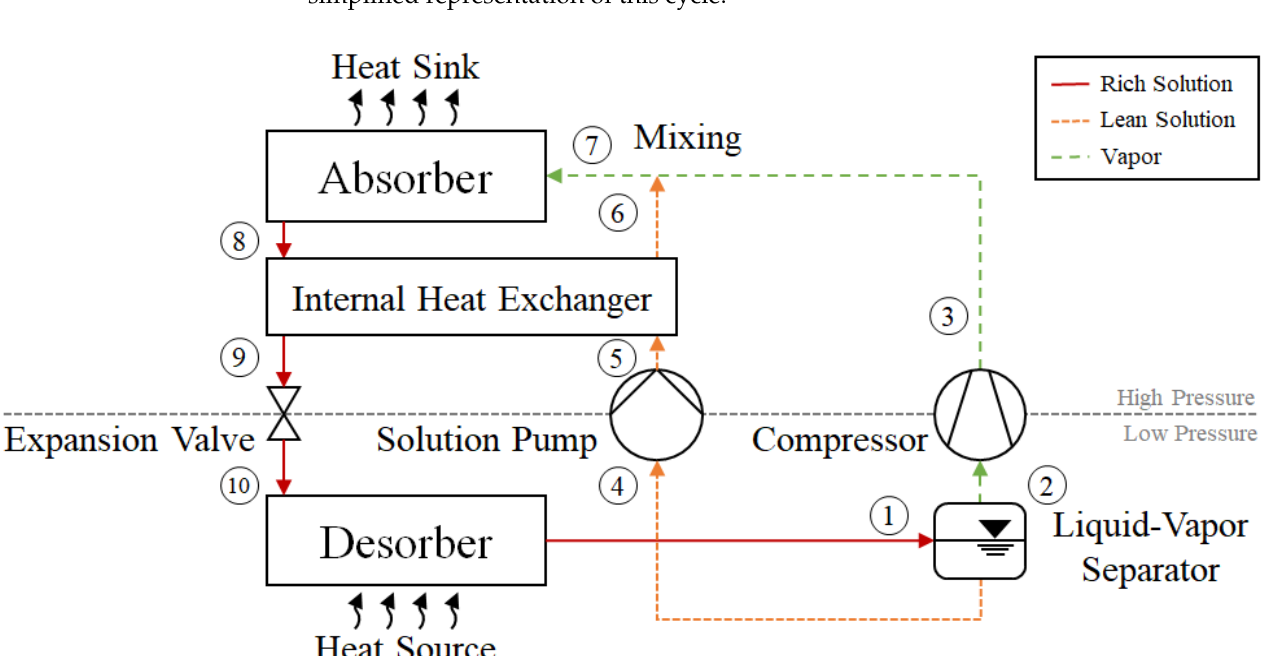
Figure 1. Schematic representation of a basic hybrid absorption–compression heat pump cycle.